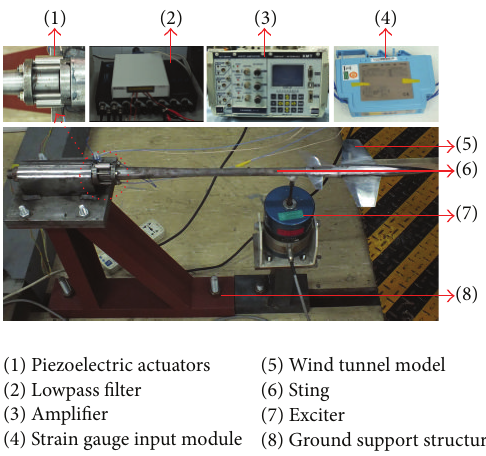
Figure 12: Ground support structure and experimental devices.